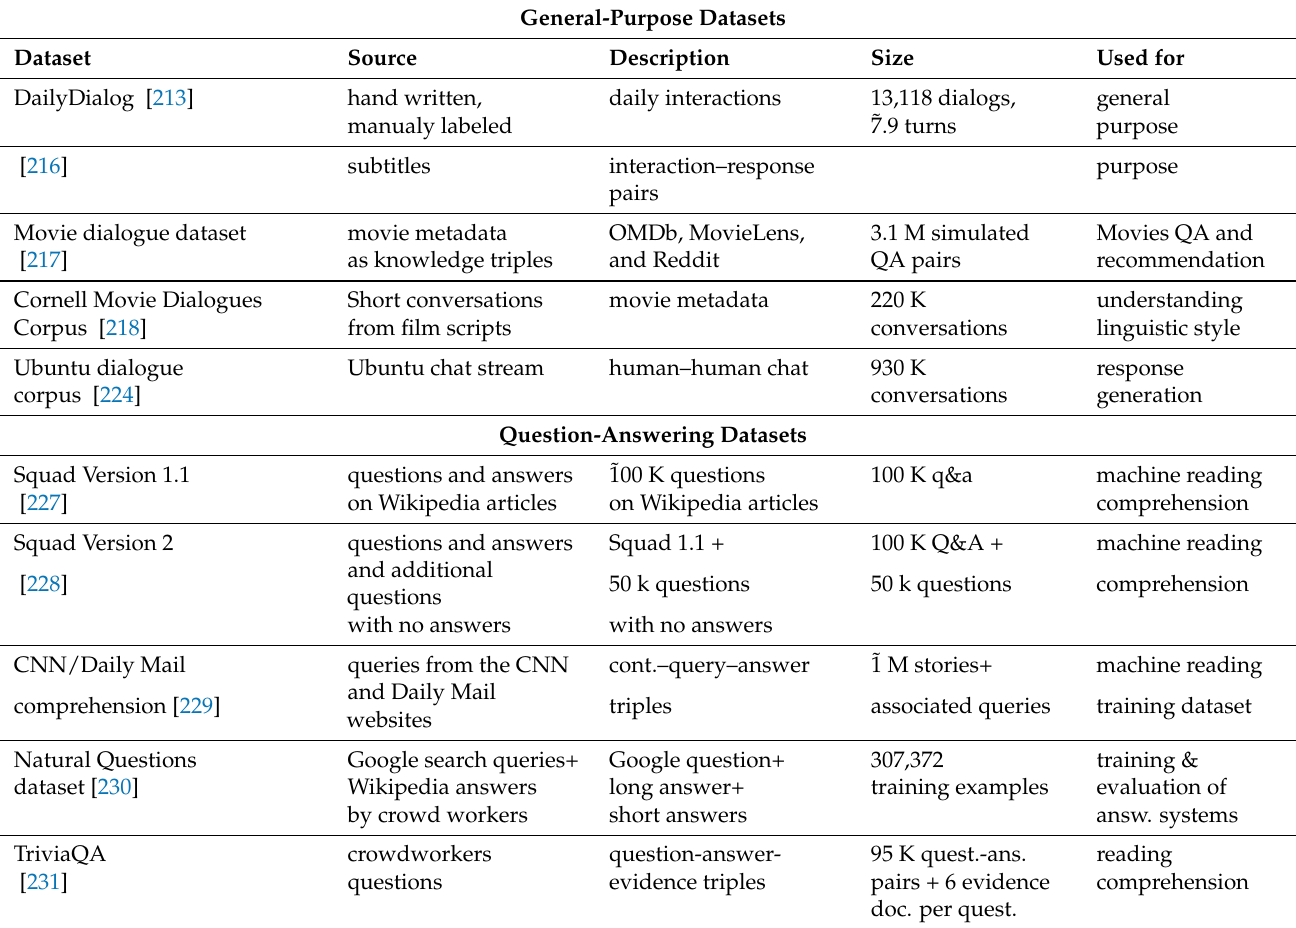
Table 3. Main available datasets for conversational agents—part